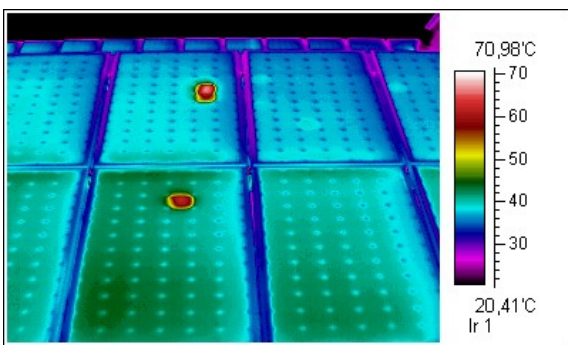
Figure 4. Defects of PV panels identified by infrared thermography (IRT) analysis [13].